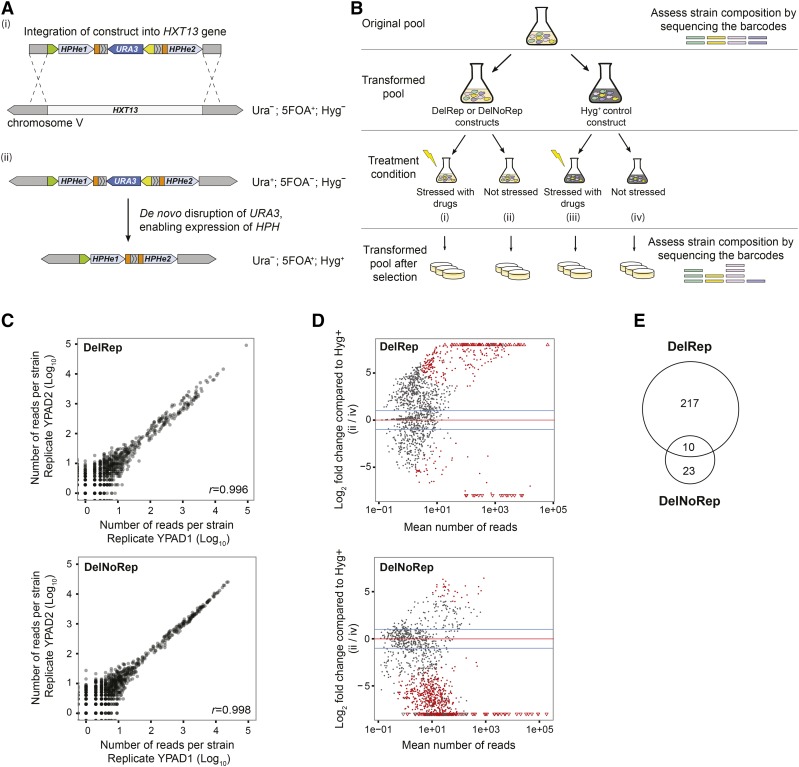
Genome-wide approach for identifying yeast knockout strains prone to acquire deletions. (A) Constructs designed to detect de novo deletions at large scale. (i) A cassette containing the HPH gene interrupted by a long intron was introduced into a nonessential region of chromosome V. Two independent versions of this construct were created, one containing direct repeats surrounding the URA3 gene (DelRep construct) and one lacking these direct repeats (DelNoRep construct; Figure S1A in File S1). Green arrow, ADH promoter; yellow arrow, URA3 promoter; gray striped boxes, Alu-derived direct repeat elements; and orange boxes, actin intron splice sites). (ii) Upon de novo deletions shortening the intron, the HPH gene can become spliced and hence confer hygromycin (Hyg) and 5FOA (5-fluorootic acid) resistance. A control construct with constitutive Hyg resistance was also designed (Figure S1A in File S1). (B) Experimental setup: the strain composition of the original pool from the yeast deletion collection was assessed by sequencing the barcodes of all strains. Aliquots of this pool were used to create transformed pools carrying the DelRep construct, the DelNoRep construct, or the control (Hyg+) construct. These pools were treated overnight (or 2 hr in the case of methyl methanesulfonate) with specific drugs (i and iii) or grown on rich media (ii and iv) without any stress. After treatment, strains that acquired deletions were enriched by selecting for Hyg resistance on plates. The final composition of the selected pools was again assessed by sequencing the barcodes of all recovered strains. (C) Pearson correlation between the number of reads per strain detected by sequencing the barcodes in two technical replicates transformed pools after selection, employing the DelRep and DelNoRep constructs without drug treatment {YPAD1 and YPAD2: each of the replicates grown in YPAD [Bacto-Yeast extract (10 g/L), Bacto-Peptone (20 g/L), Dextrose (20 g/L), and Adenine sulfate (0.4 g/L)] without any drug}. (D) Log2 fold changes over the mean of normalized read counts for transformed DelRep- and DelNoRep-based pools after selection [see also (ii) in (B)] relative to the Hyg+ control [see also (iv) in (B)] without drug stress applied. Strains significantly enriched at a False Discovery Rate of 10%, and with at least twofold increase, are highlighted in red. (E) Intersection of significantly enriched strains carrying the DelRep or the DelNoRep constructs.